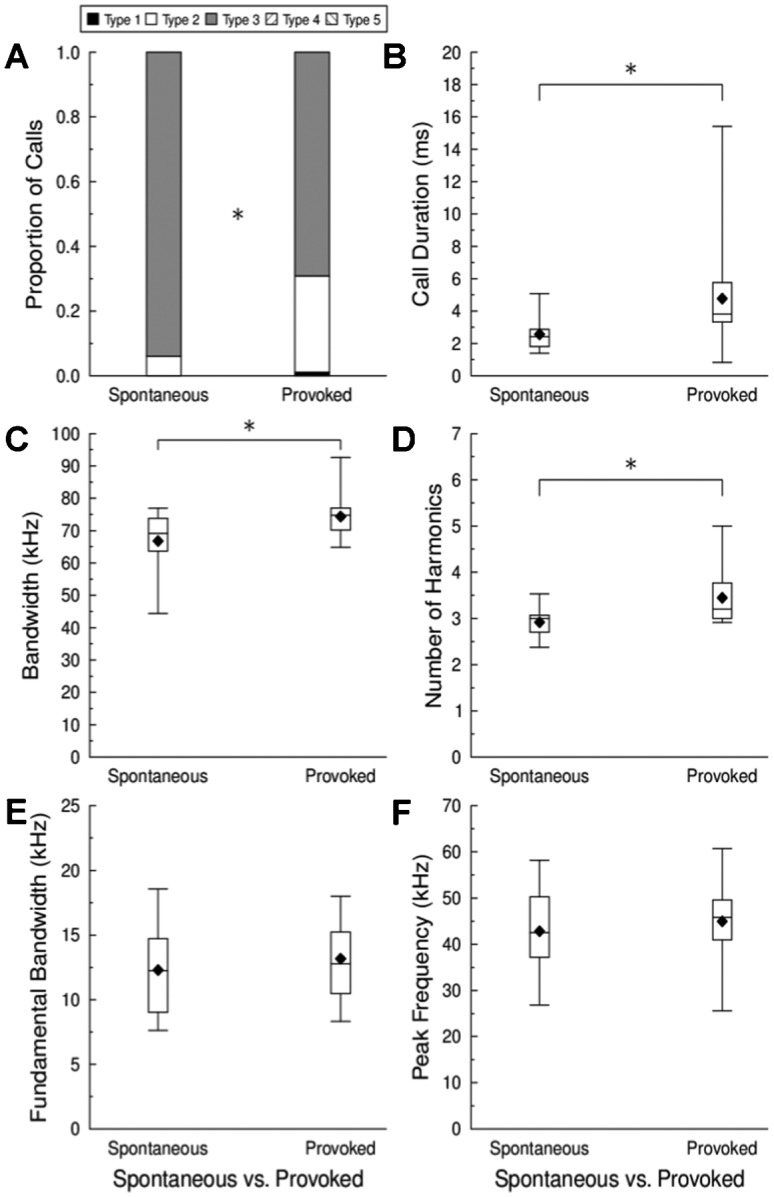
Change in call types and their acoustic parameters for spontaneous and provoked vocalizations of E. fuscus pups on PND 13 (n = 16).(A) Call type proportions for spontaneous and provoked vocalizations. Box and whisker plots comparing the (B) call duration, (C), signal bandwidth (D), number of harmonic elements (E), bandwidth of the fundamental acoustic element, and (F) peak spectral frequency of spontaneous and provoked vocalizations. The line within a box is the median, the edges are the 25th and 75th percentiles, the whiskers are the minimum and maximum values, and the filled diamond is the mean. * = p<0.05.